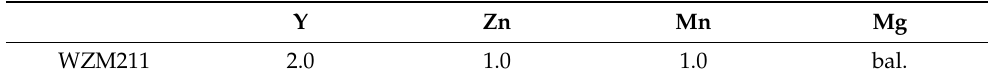
Table 2. Nominal composition of WZM211 alloy